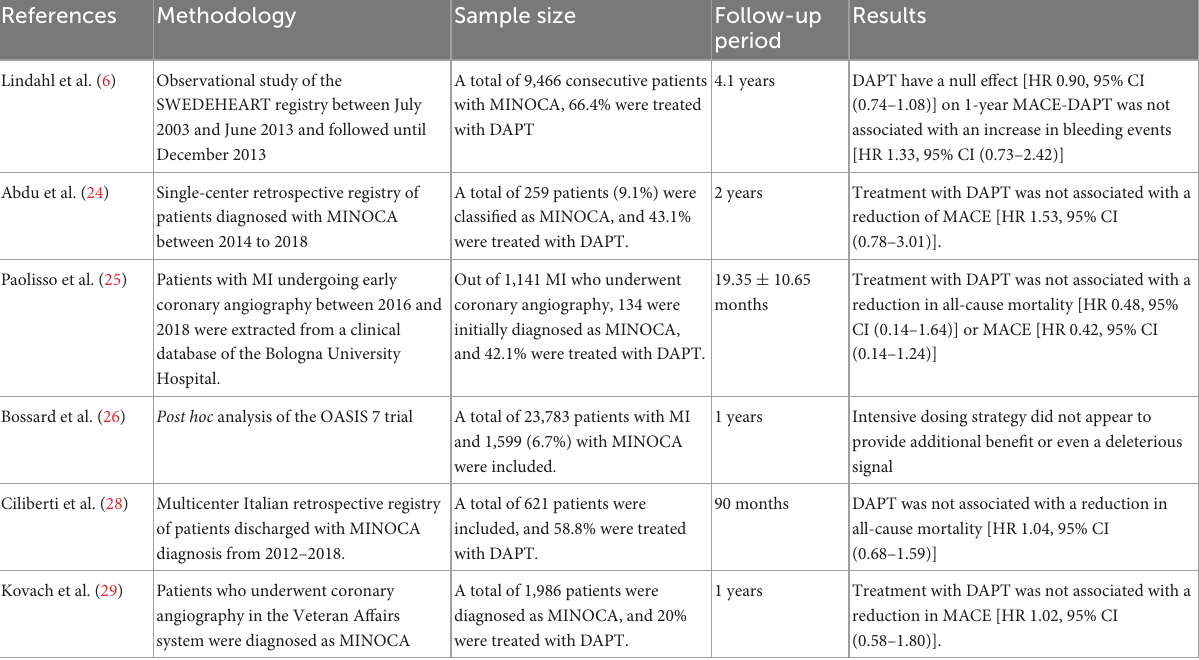
TABLE 1 Summary of the relevant studies related to antiplatelet agents for